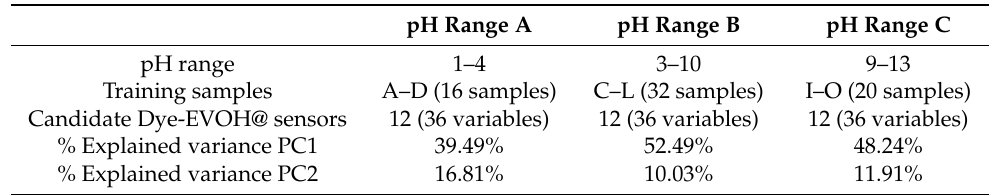
Table 4. pH range, correspondent training samples, candidate Dye-EVOH@ sensors, and % explained variance for pH ranges A, B, and C.